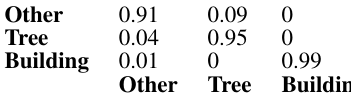
Figure 5. Different tree representations (octagon,